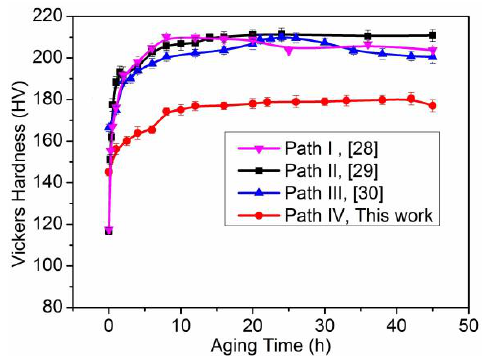
Figure 11. Hardness variations with the aging time with the different paths.